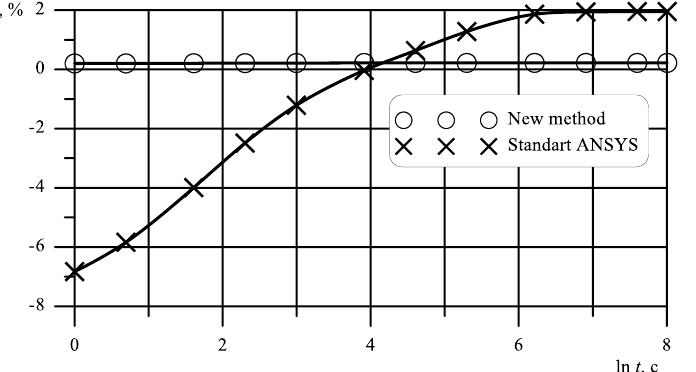
Fig. 3. The relative discrepancy of solutions of the problem of bending, obtained by different methods with respect to the analytical